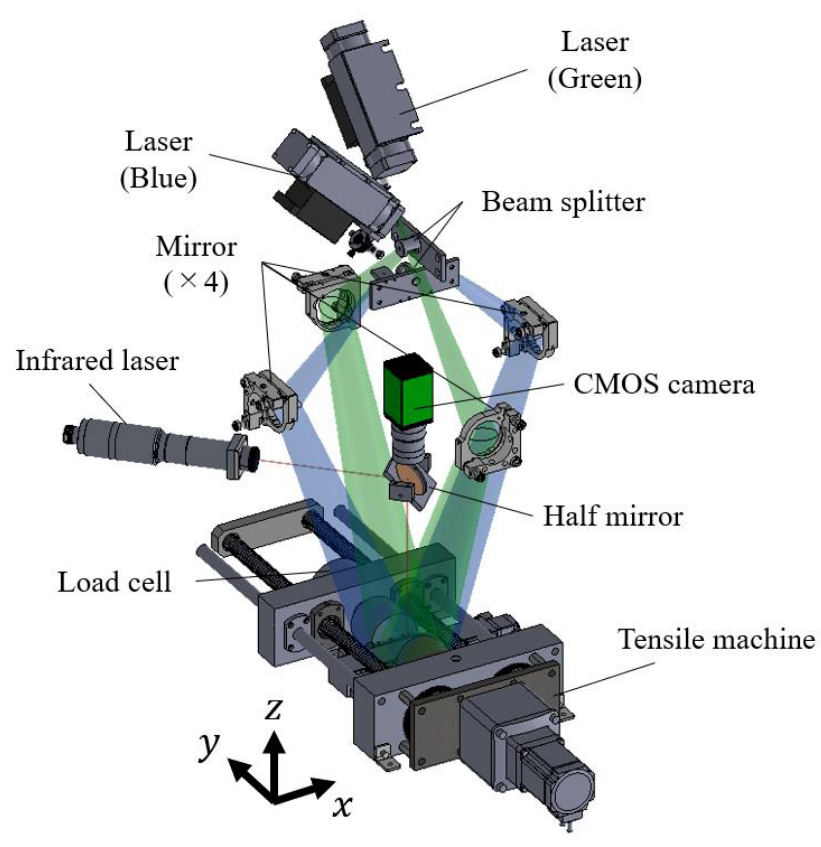
Figure 2. Optical setup and devices for local spot heating test under the stressed condition.